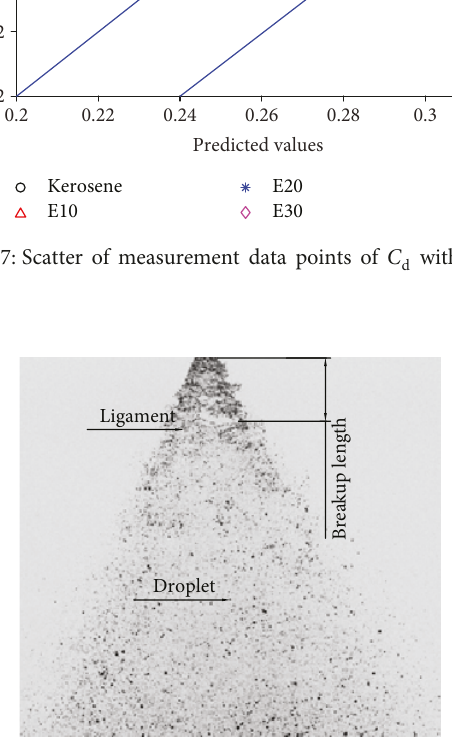
Figure 8: Breakup length of swirl liquid from pressure-swirl